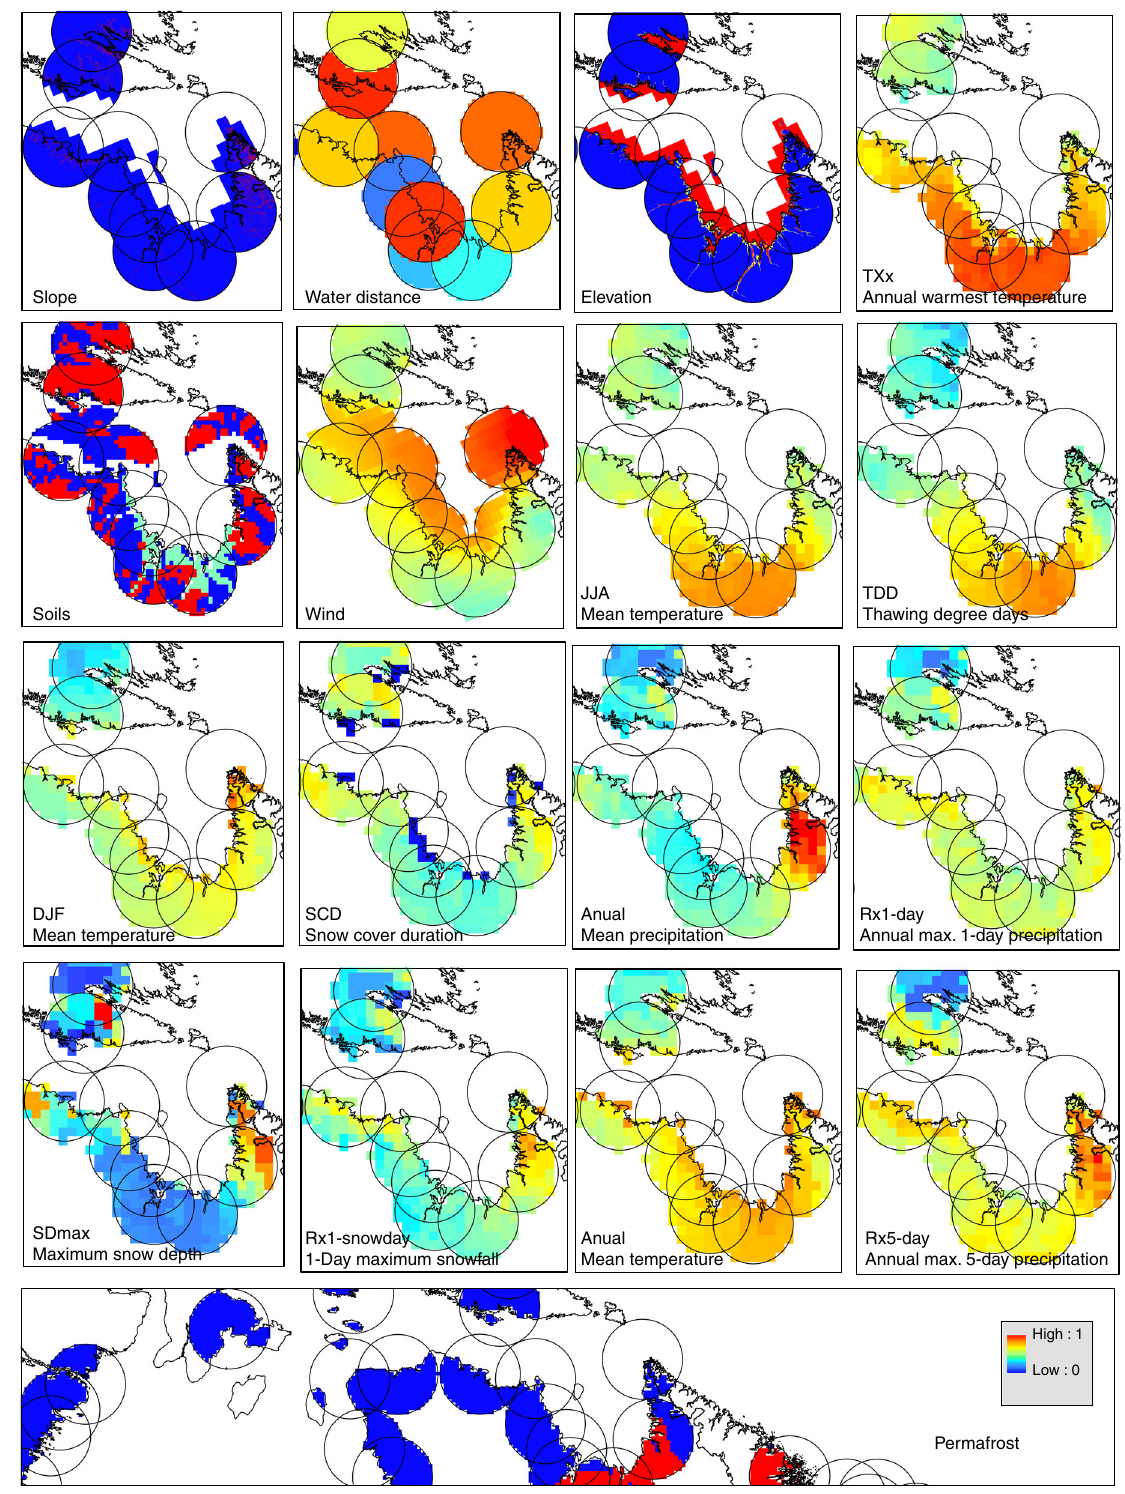
Fig. 7 Normalized climate variables, extreme indices and physical features. Values were rescaled from 0 – 1 to combine with other